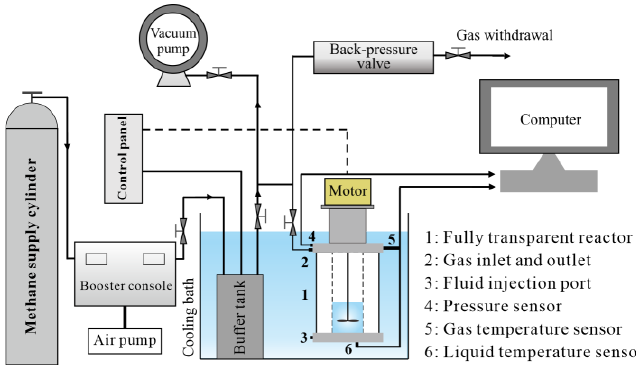
Figure 13. The fully transparent hydrate formation and dissociation experimental apparatus.